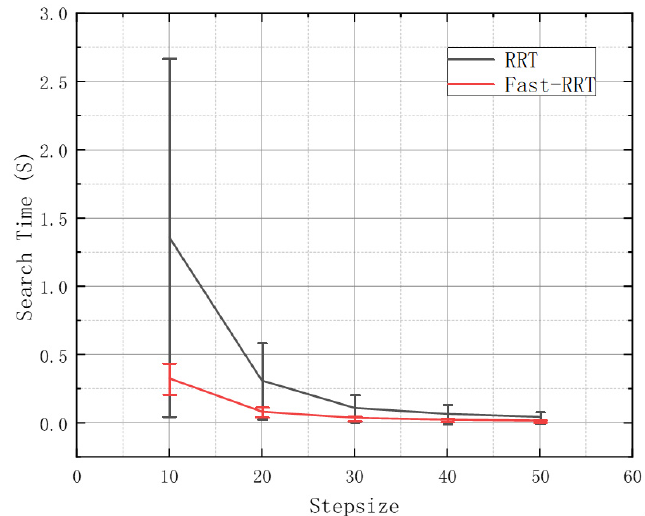
Figure 12. Comparison of the search time between RRT algorithm (black) and Improved-RRT algorithm (red) with different step sizes.